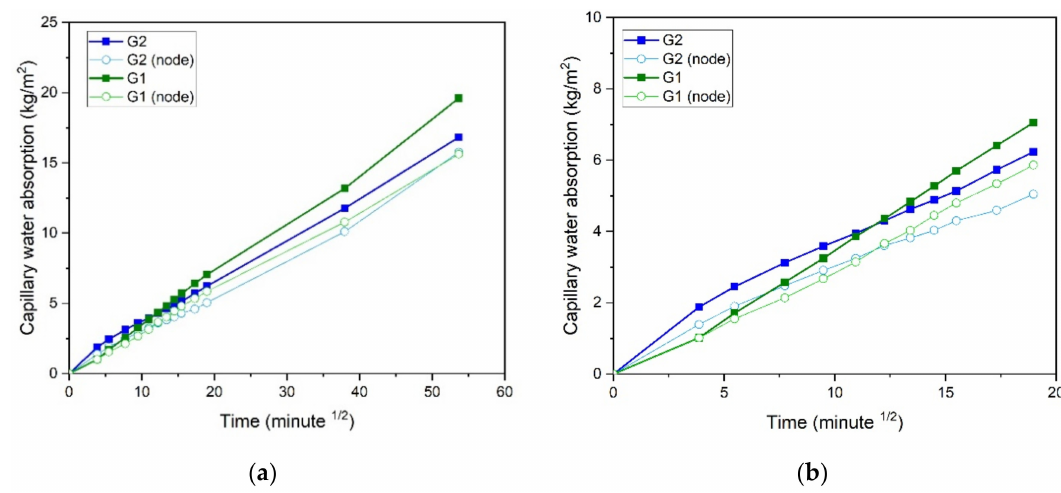
Figure 10. Capillary water absorption as a function of the square root of test time: ( a ) complete curves and ( b )